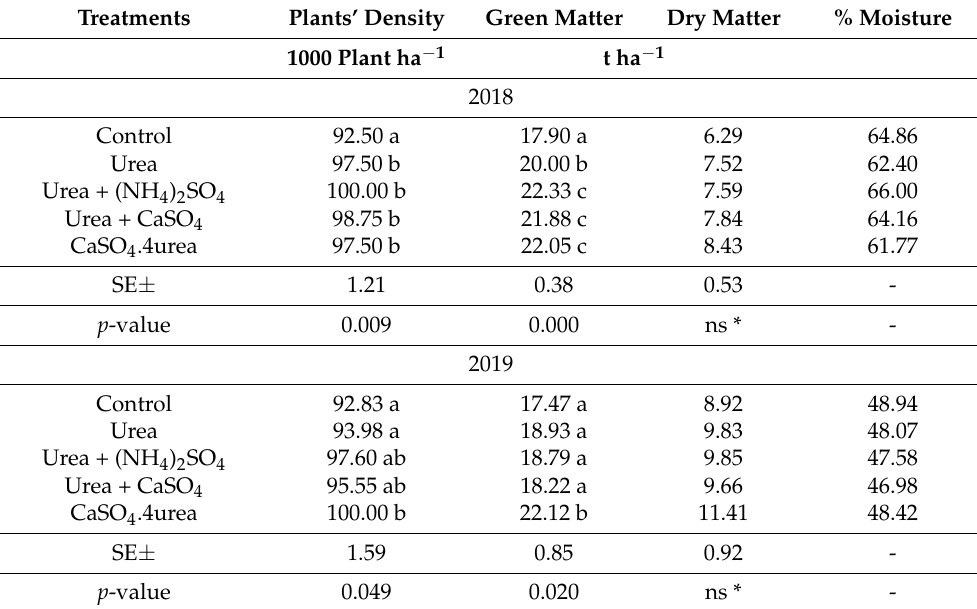
Table 3. Means of plants’ density, total fresh and dry matter yields after using urea-sulfur fertilizers for the 2-year study